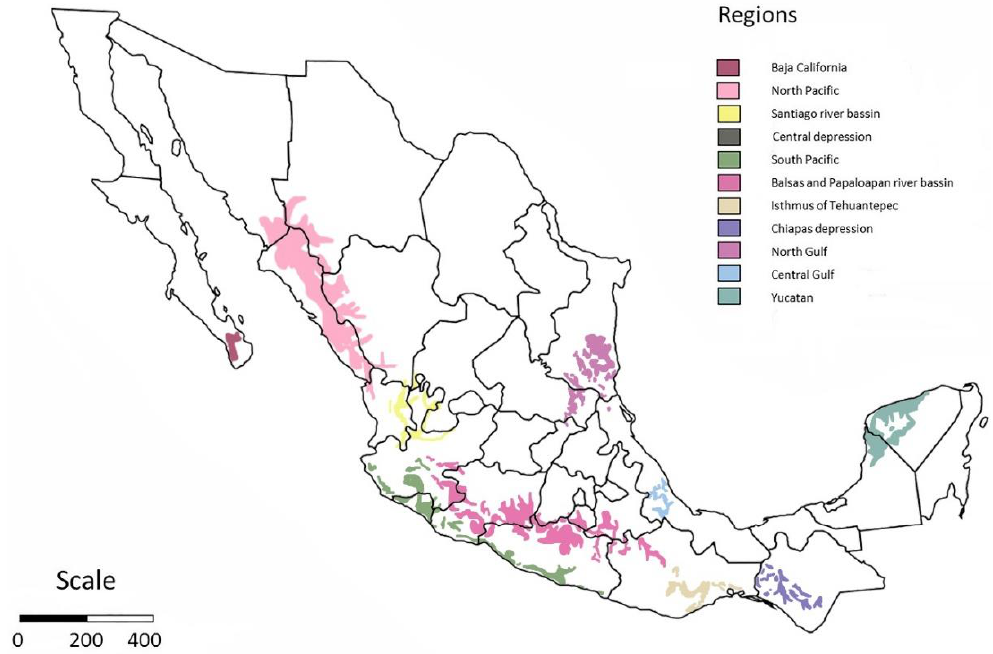
Figure A1. Main subdivisions of the tropical dry forest of Mexico according to [26]. Scale in km.